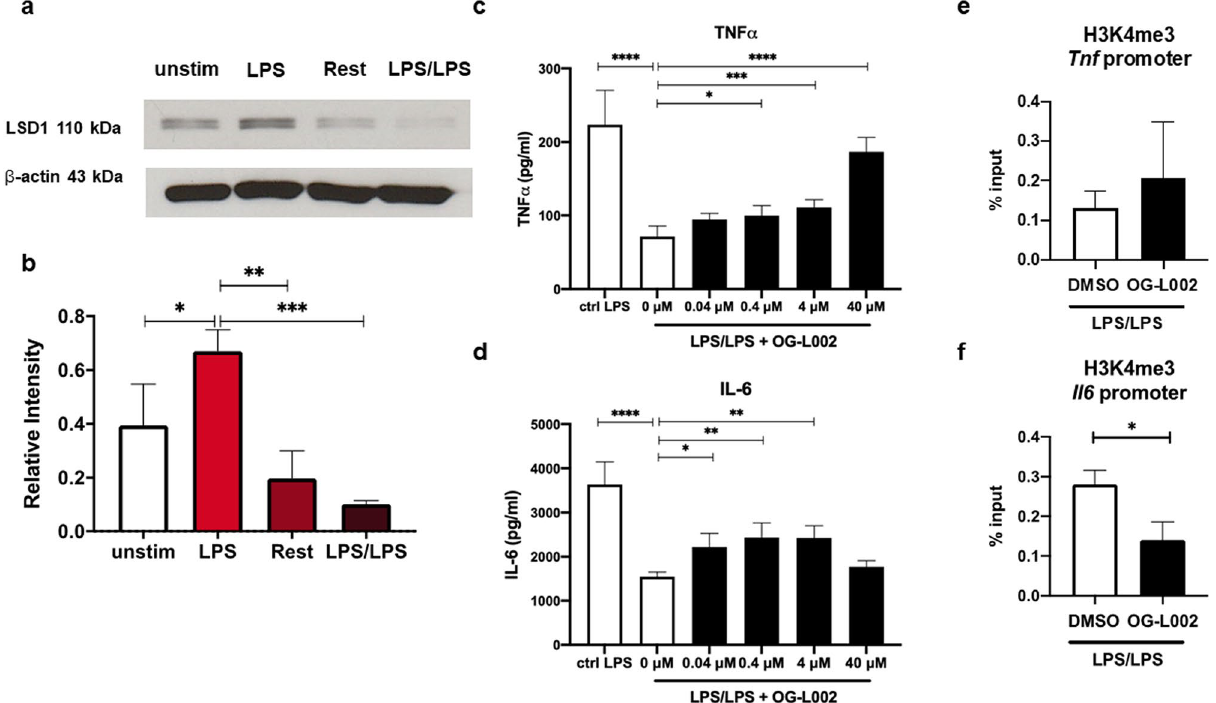
Figure 6. Expression profiles of LSD1 during LPS tolerance in macrophages. BMMs were induced to become LPS tolerance as described above. ( a , b ) Expression profiles was analyzed by Western blot. The relative intensity of LSD1 from Western blot was quantitated by ImageJ analysis and normalized to β-actin. ( c , d ) Effect of OG-L002 on TNFα and IL-6 production in LPS-tolerant macrophages. ( e , f ) Effect of OG-L002 on H3K4me3 enrichment in Tnf and Il6 promoter of LPS-tolerant macrophages at 6 h after LPS stimulation. *, **, *** and **** indicate significant differences compared by one-way ANOVA with Tukey’s multiple test ( c,d ) and two-tailed unpaired t-test ( e , f ) at p < 0.05, p < 0.01, p < 0.001 and p < 0.0001,